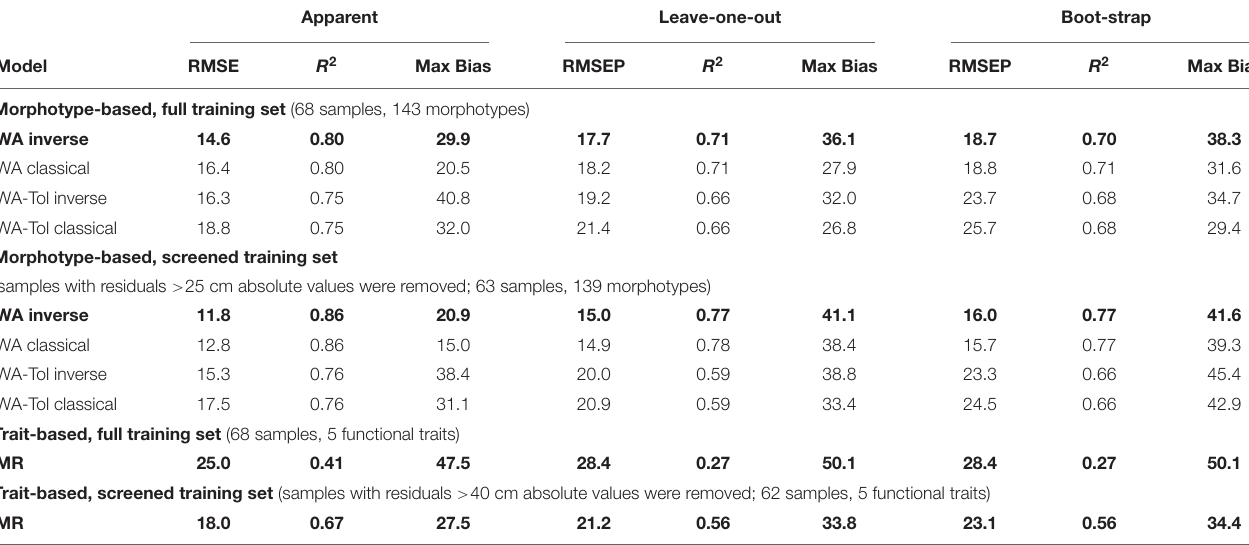
TABLE 2 | Performance statistics for the morphotype- and trait-based transfer functions (weighted averaging (WA) and multiple regression (MR) models) for reconstruction of water table depth. Apparent Leave-one-out